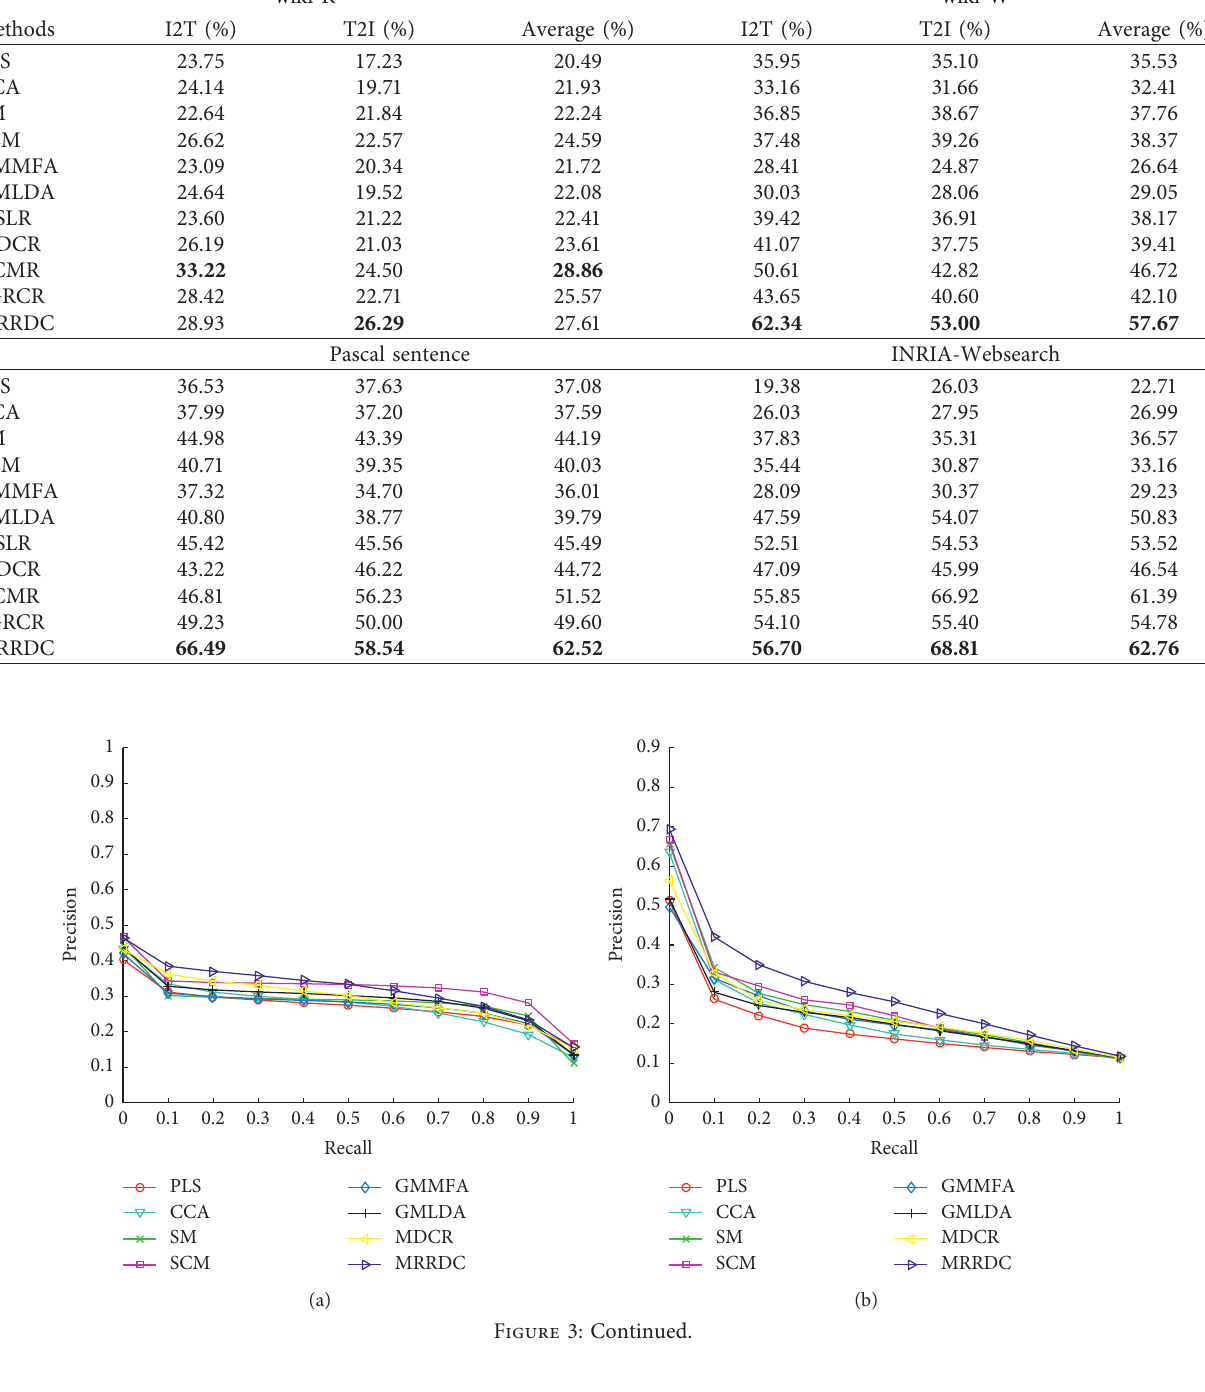
Table 1: Retrieval performance (mAP) on three public datasets.